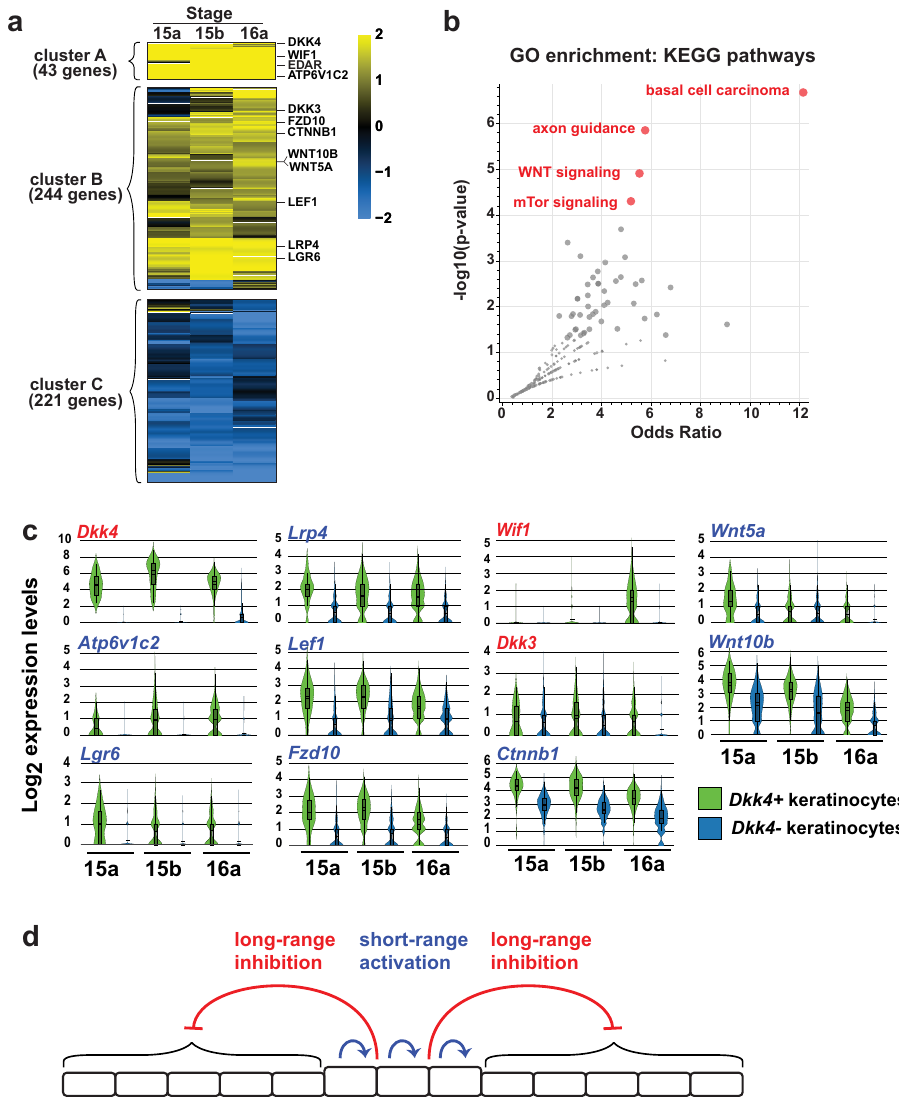
Fig. 3 Patterns of differential gene expression and gene ontology analysis in basal keratinocyte subpopulations. a Heatmap of gene expression difference (log 2 fold-change) in Dkk4 -positive compared to Dkk4 -negative keratinocytes. b Ontology analysis for genes that are highly (cluster A) or moderately (cluster B) upregulated identi fi es four KEGG pathways that are signi fi cantly enriched in Dkk4 -positive cells. c Expression levels for Wnt pathway genes depicted as violin plots. Embedded box and whisker plots depict population maxima and minima (whiskers), fi rst and third quartile boundaries (boxes), mean (solid lines), and median (broken lines). Approach to the analysis of differential expression ( a ) and ontology ( b ) and assessment of individual gene expression levels ( c ) are described in the text. d A reaction − diffusion model for color pattern establishment in the basal epidermis where Wnt pathway components participate in both short-range activation and long-range